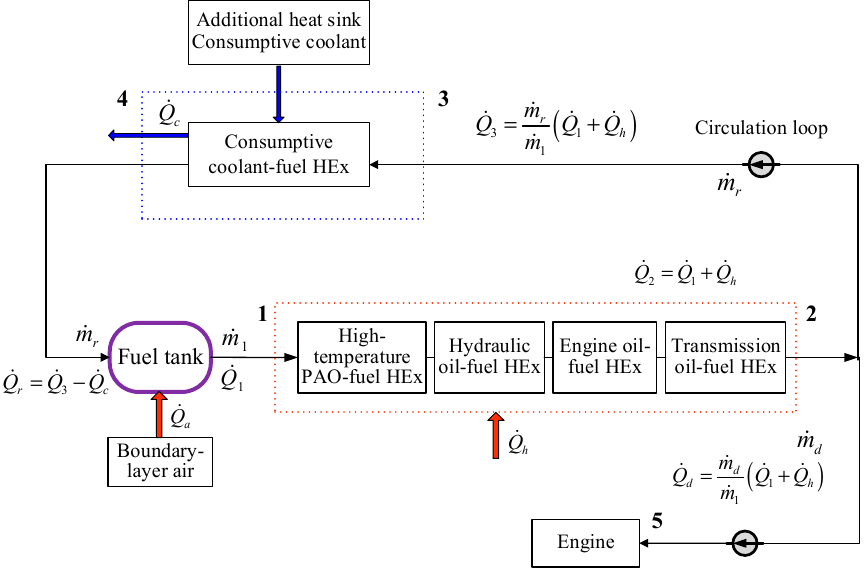
Figure 1. Fuel thermal management system configuration for a high-speed vehicle.